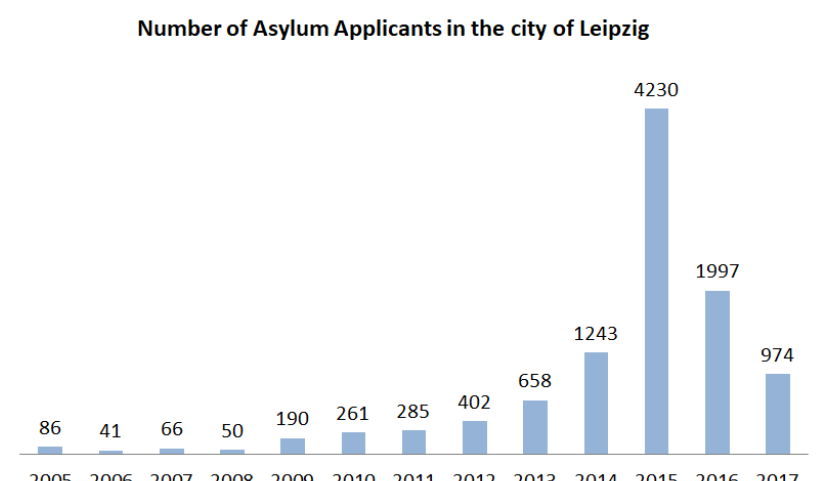
Figure 1. Asylum applicants that were assigned to the city of Leipzig. Source: Office for Social Affairs of the city of Leipzig (Stadt Leipzig, 2018a, p.